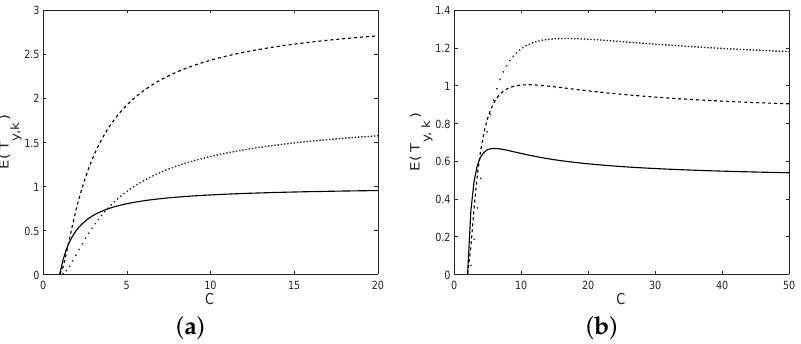
Figure 12. The mean of T y , k is plotted as a function of C ; ( a ): for y = 1 and k = 2 (solid), k = 3 (dotted), k = 4 (dashed); ( b ): for y = 2 and k = 3 (solid), k = 4 (dashed), k = 5